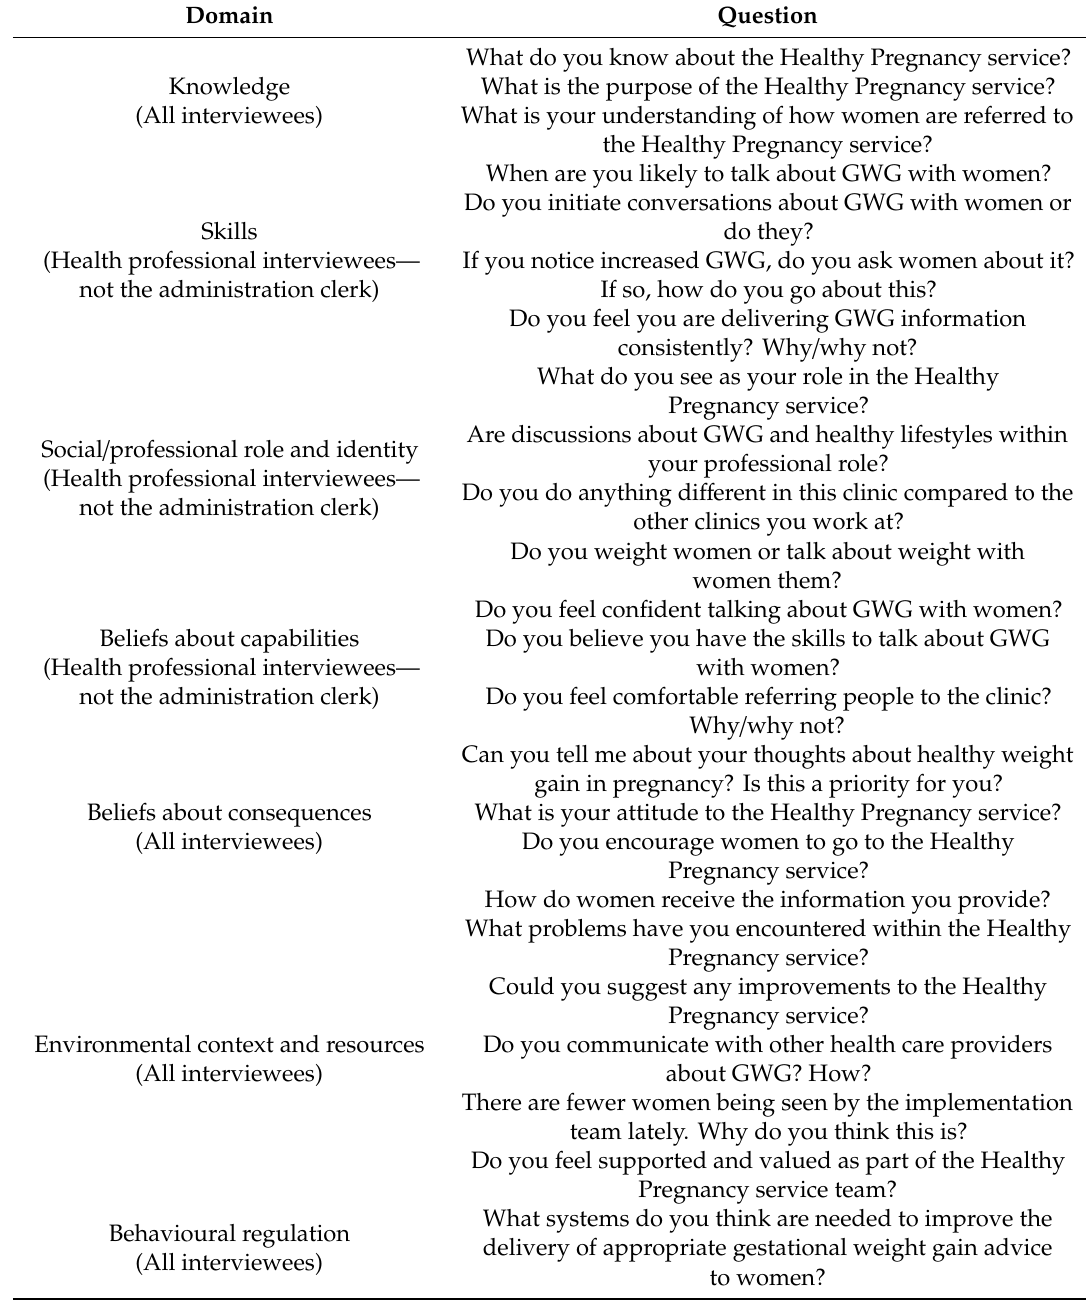
Table 1. Semi-structured interviews questions mapped to